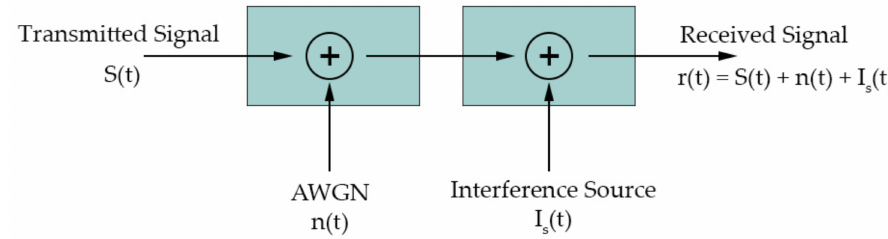
Figure 5. Signal received also contains noise and interference added in the